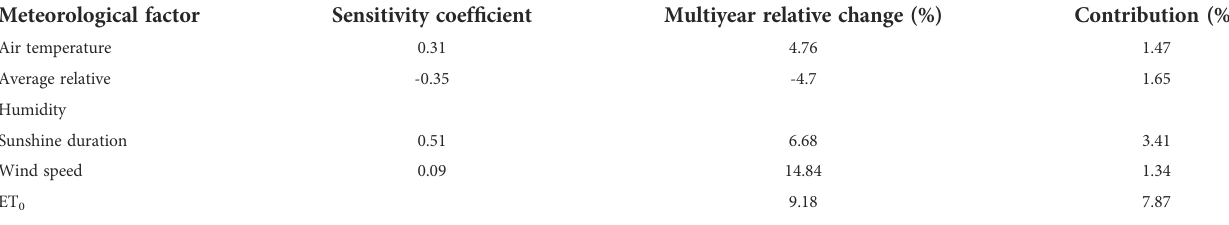
TABLE 6 Sensitivity coef fi cient of meteorological elements in Xishuangbanna, their relative changes over the years and their contributions to ET 0 change. Meteorological factor